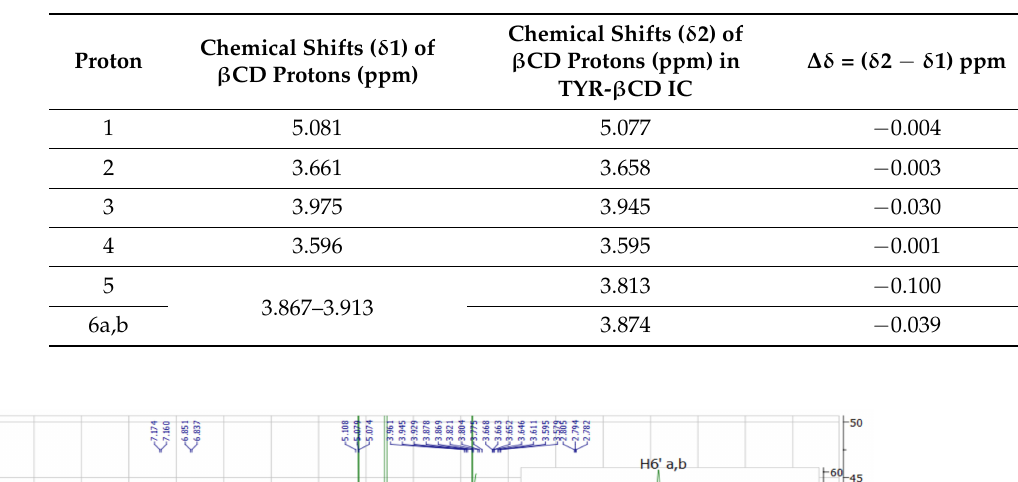
Table 6. Chemical shift changes of 1 H-NMR signals of β CD before and after the formation of the TYR- β CD IC.